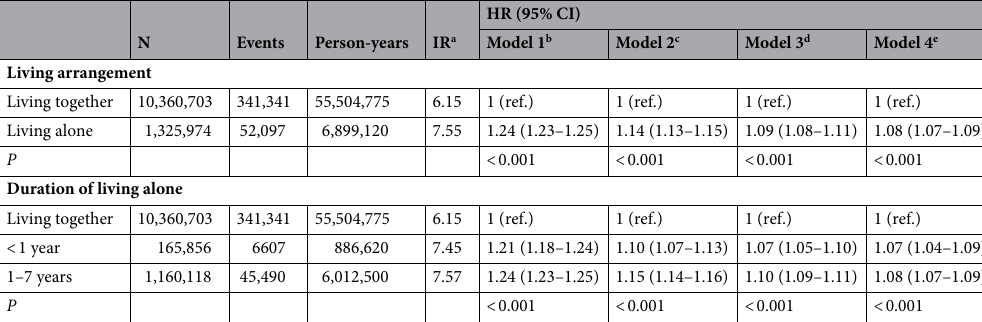
Table 2. Associations between living arrangement and risk of incident type 2 diabetes mellitus. IR incidence rate, HR hazard ratio, CI confidence interval. a Incidence of type 2 diabetes mellitus per 1000 person-years. b Model 1 was unadjusted. c Model 2 was adjusted for age and sex. d Model 3 was adjusted for age, sex, smoking status, alcohol consumption, physical activity, and income. e Model 4 was adjusted for age, sex, smoking status, alcohol consumption, physical activity, income, body mass index, hypertension, and dyslipidemia.